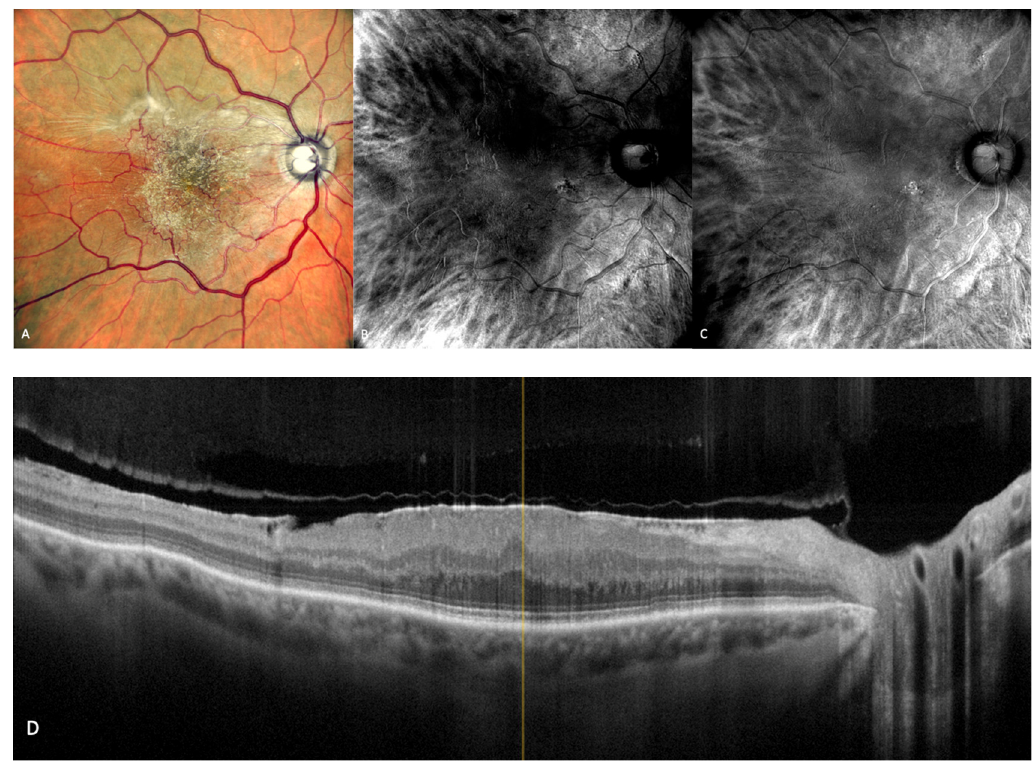
Figure 9. Epiretinal membrane (ERM). ( A ) cSLO image showing ERM folds on the retinal surface. ( B , C ) Retromode DR and DL images represent a characteristic “fingerprint” aspect [56]. ( D ) SD-OCT showing the irregular hyper-re fl ective layer on the retinal surface.